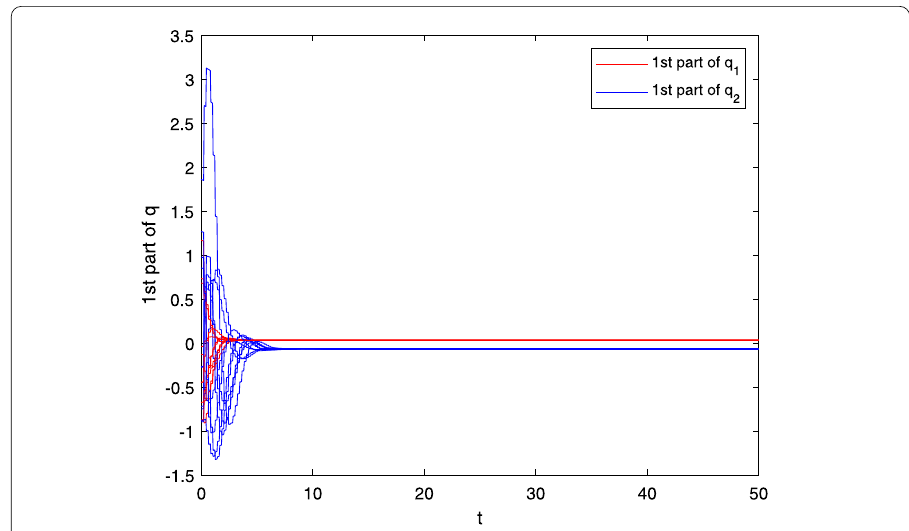
Figure 1 The first part of the state trajectories for system (1) with parameters